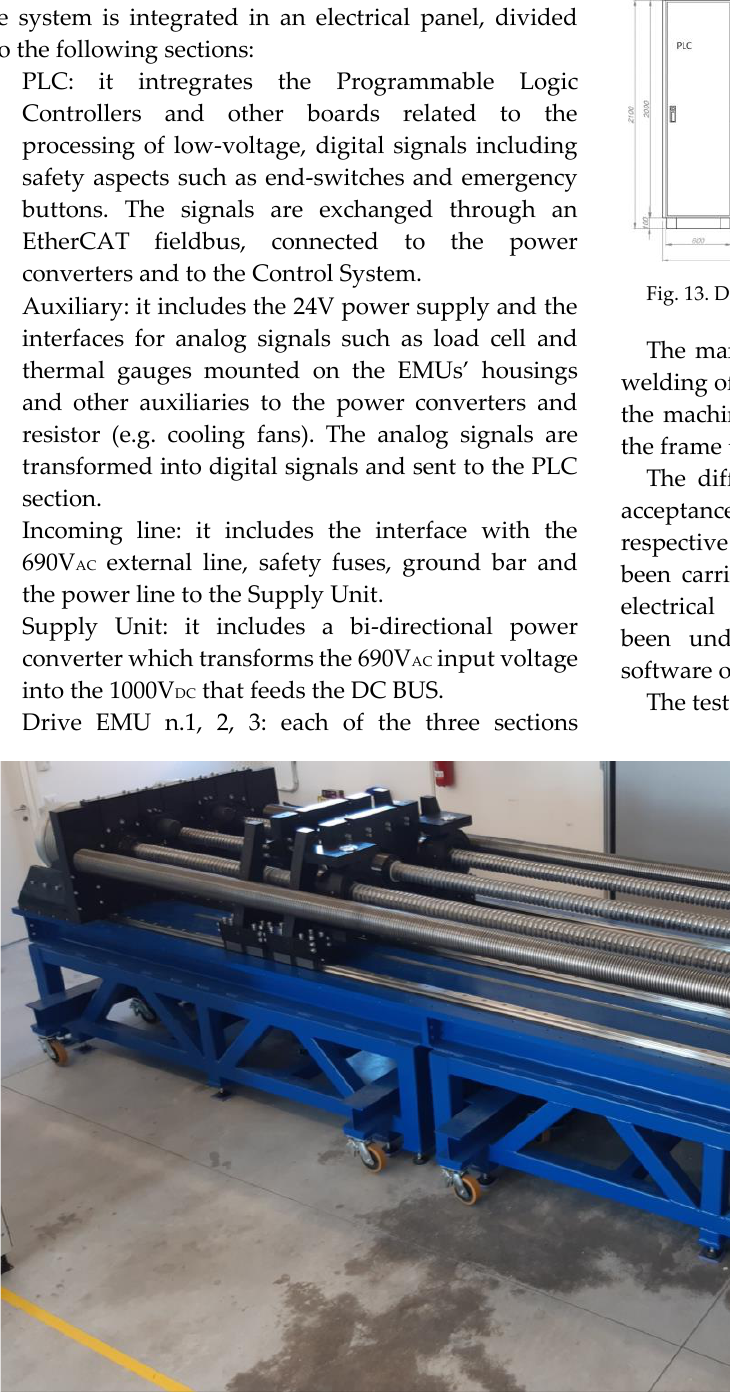
Fig. 14. HIL test rig mechanical